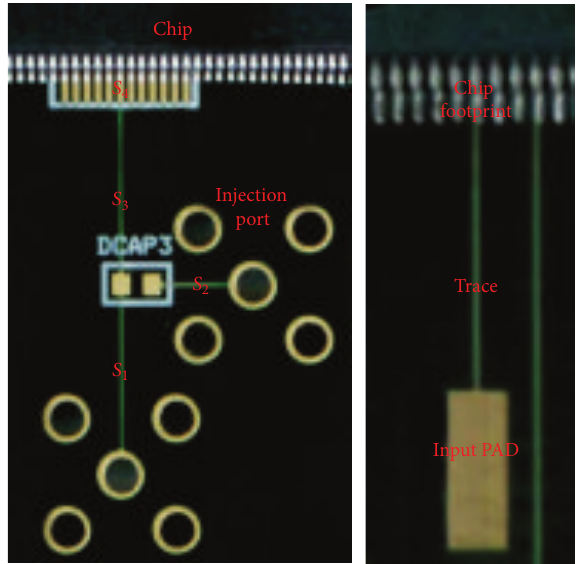
Figure 11: Overview of PCB trace used in DPI